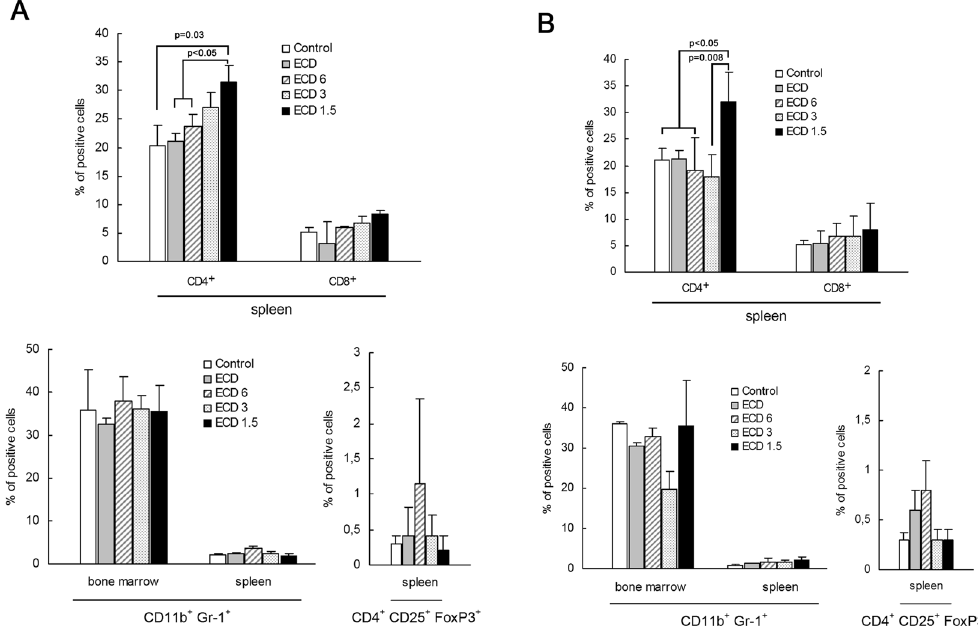
Figure 4. Effect of BI on the leukocyte phenotype. Spleen or bone marrow cells from 76 ( A ) or 96 ( B ) week- old immunized mice were stained with moAbs specific for the following antigens: CD8a (Ly-2), CD4 (L3T4), CD4 + CD25 + Foxp3 + (regulatory T cells), and CD11b + Gr-1 + (myeloid-derived suppressor cells) and analyzed